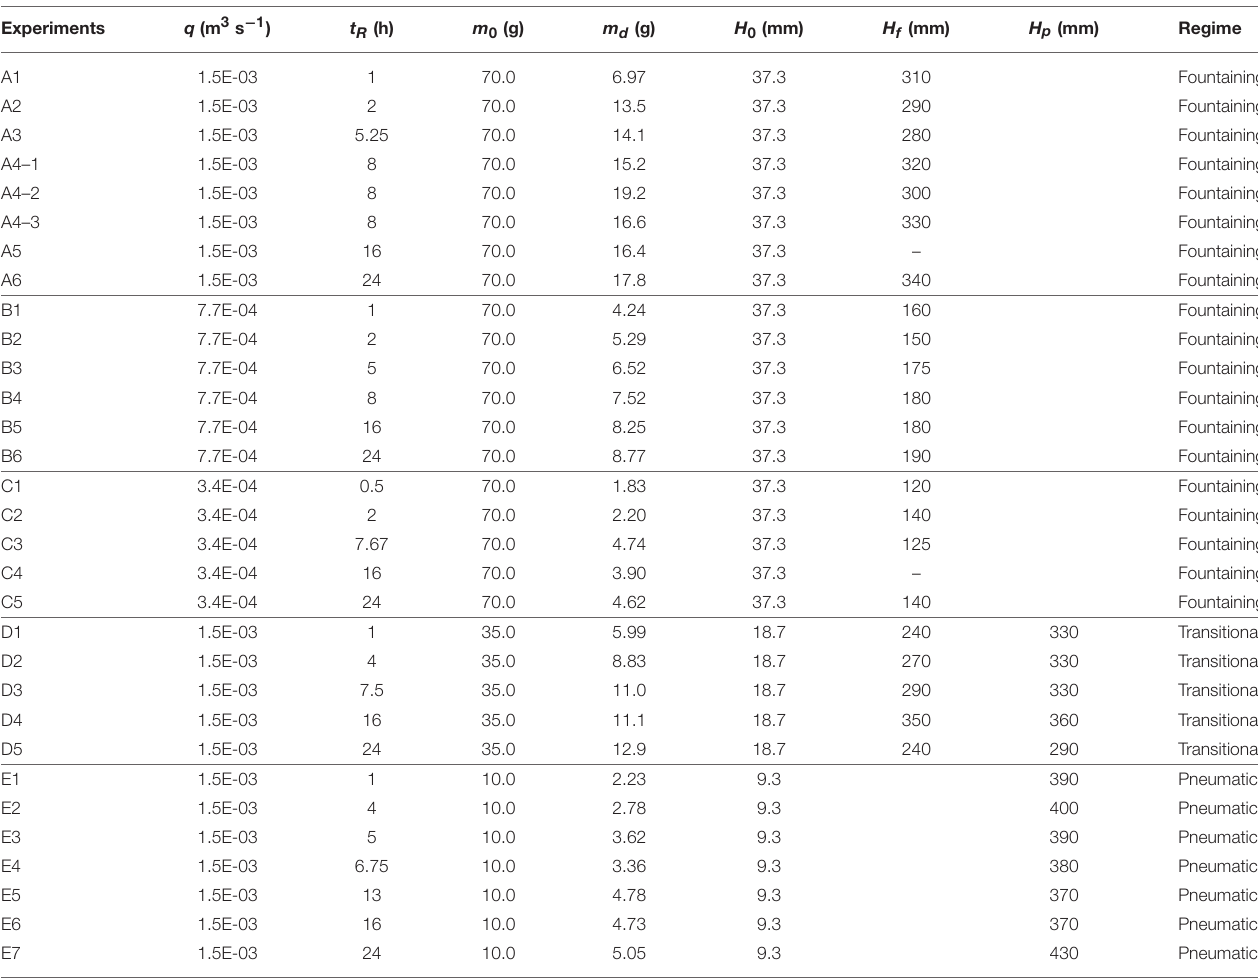
TABLE 1 | Summary of experiments conducted in this study.